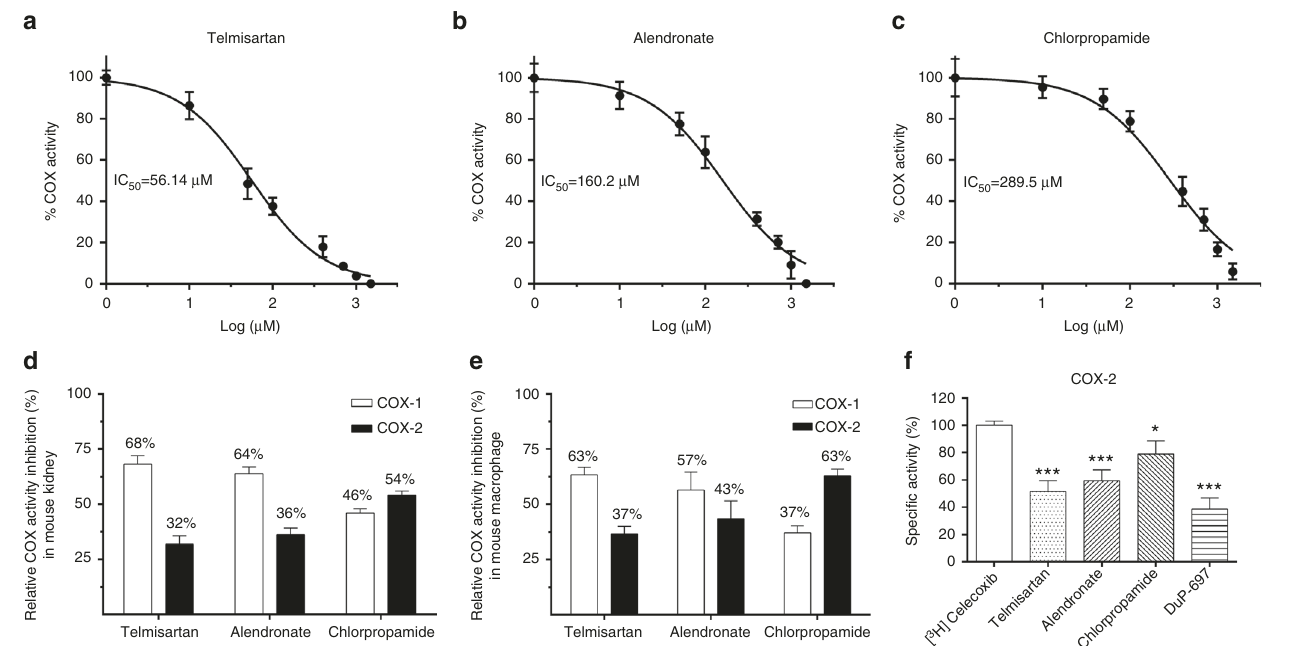
Fig. 6 Inhibitory effects of telmisartan, alendronate and chlorpropamide on COX activity measured by COX inhibition assays. a – c The inhibition rates of telmisartan, alendronate and chlorpropamide measured by the COX fl uorescent activity assays on the mouse kidney lysates. d , e The relative COX activity inhibition rates of telmisartan, chlorpropamide and alendronate on COX-1 and COX-2, measured by the COX fl uorescent activity assays on the tissue extracts from both kidney d and macrophage e lysates. f The results on the competitive binding of [ 3 H] celecoxib for different COX-2 inhibitors measured by the radioligand-based binding assays. Control: the radioactivity of the sample with [ 3 H] celecoxib only. *: P < 0.05, **: P < 0.01, ***: P < 0.001, Newman – Keuls multiple comparison test. Here, data show the mean with the standard deviation of three independent experiments, each of which was performed with